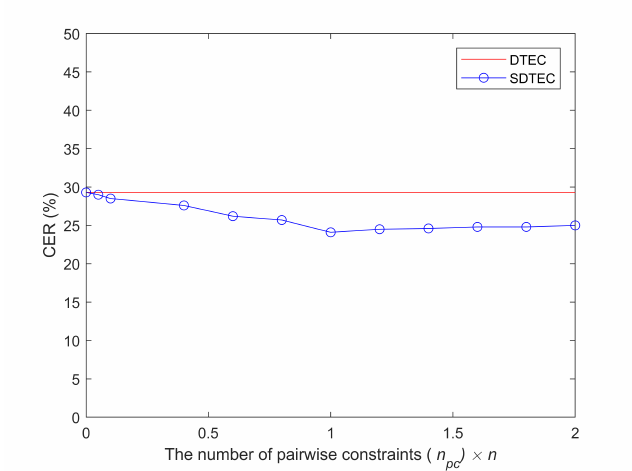
Figure 6. Ablation study in different number of